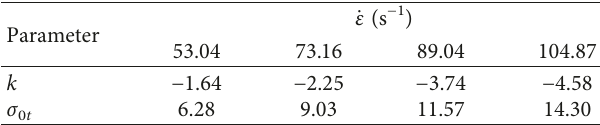
Table 2: Change of the tensile strength of the specimens against the water